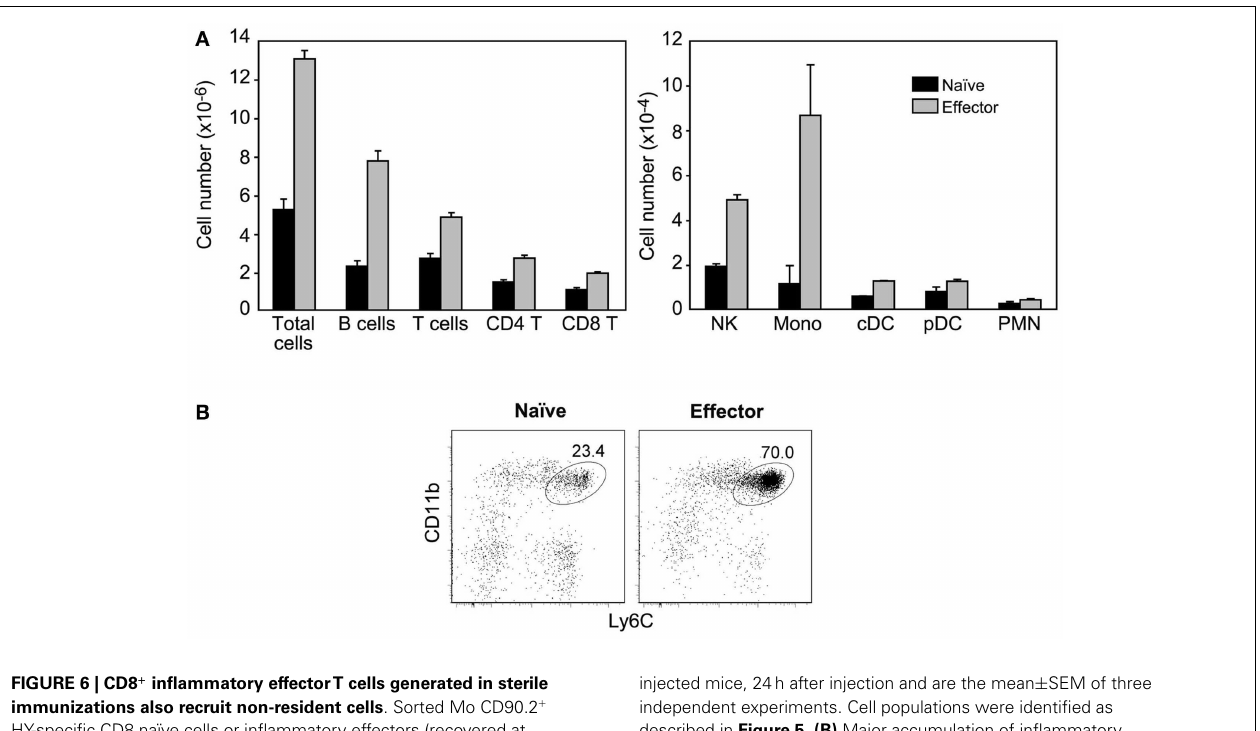
FIGURE 6 | CD8 + inflammatory effectorT cells generated in sterile immunizations also recruit non-resident cells . Sorted Mo CD90.2 + HY-specific CD8 naïve cells or inflammatory effectors (recovered at 2.5days after immunization with male cells) were injected with matrigel subcutaneously in the ear of CD90.1 + mice. (A) Results show the number of different cell types recovered in the ALN of